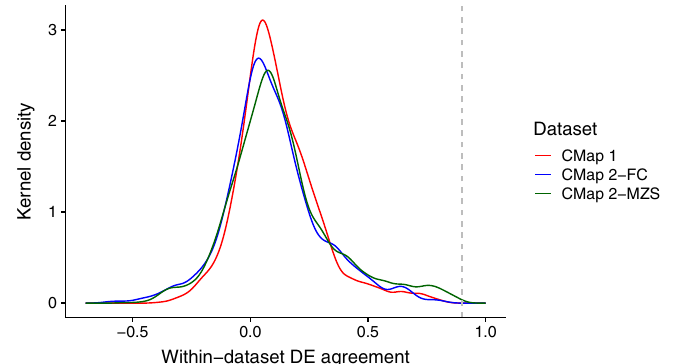
Figure 3. Distribution of maximum (“best case”) pairwise rank correlation for DE profile replicates of the same condition calculated using all genes, within each dataset. The number of unique conditions assessed for CMap 1, CMap 2-FC and CMap 2-MZS are 1614, 2416 and 2477 respectively. The dotted grey line indicates the minimum (“worst case”) rank correlation of DE for intra-platform cross-laboratory comparisons reported by MAQC (r s =